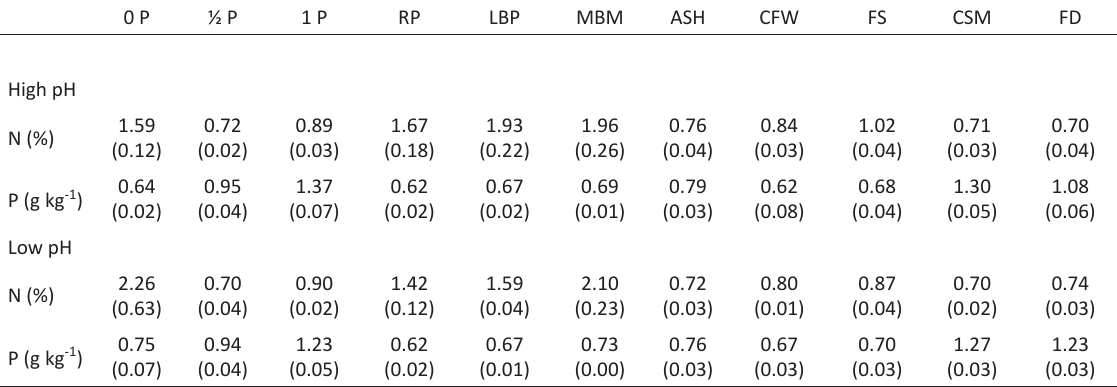
Table 2. N and P concentration in plant tissue at harvest. Values are averages with standard error in brackets (n=3). 0 P ½ P 1 P RP